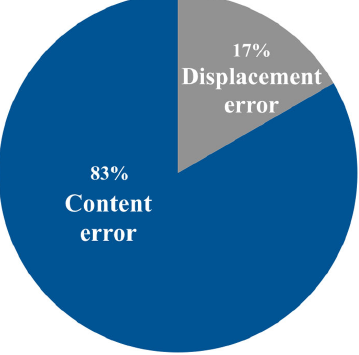
FIG. 9. Displacement and content error categories of difficulty topics for questions that do not require